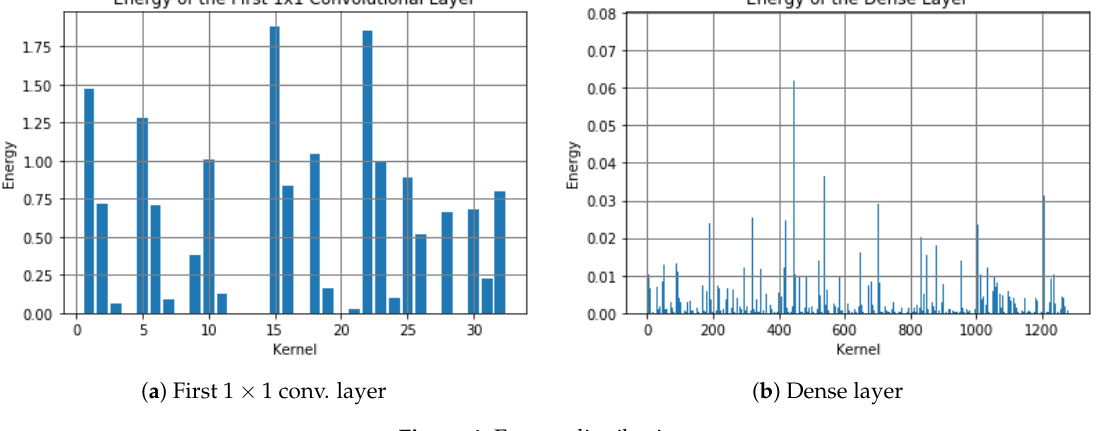
Figure 4. Energy distribution.